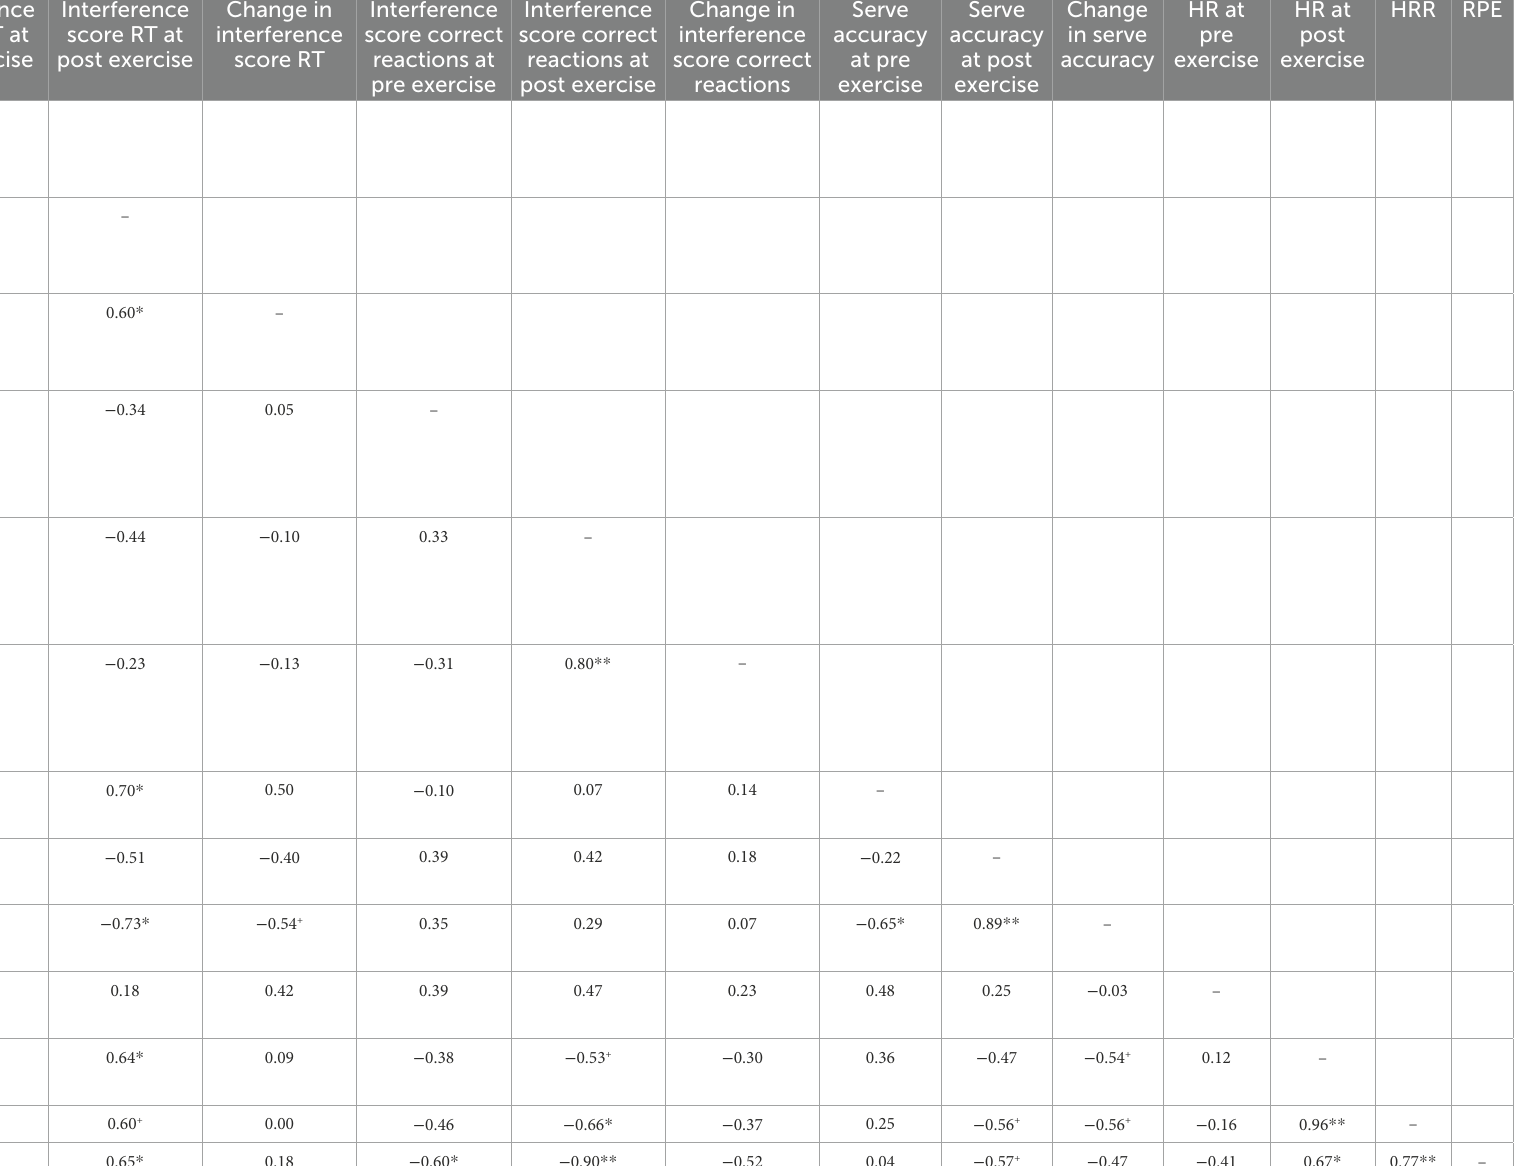
TABLE 2 Relationship between RPE, interference score, and serve accuracy. Interference Interference Change in Interference score RT at score RT at interference score correct pre exercise post exercise score RT reactions